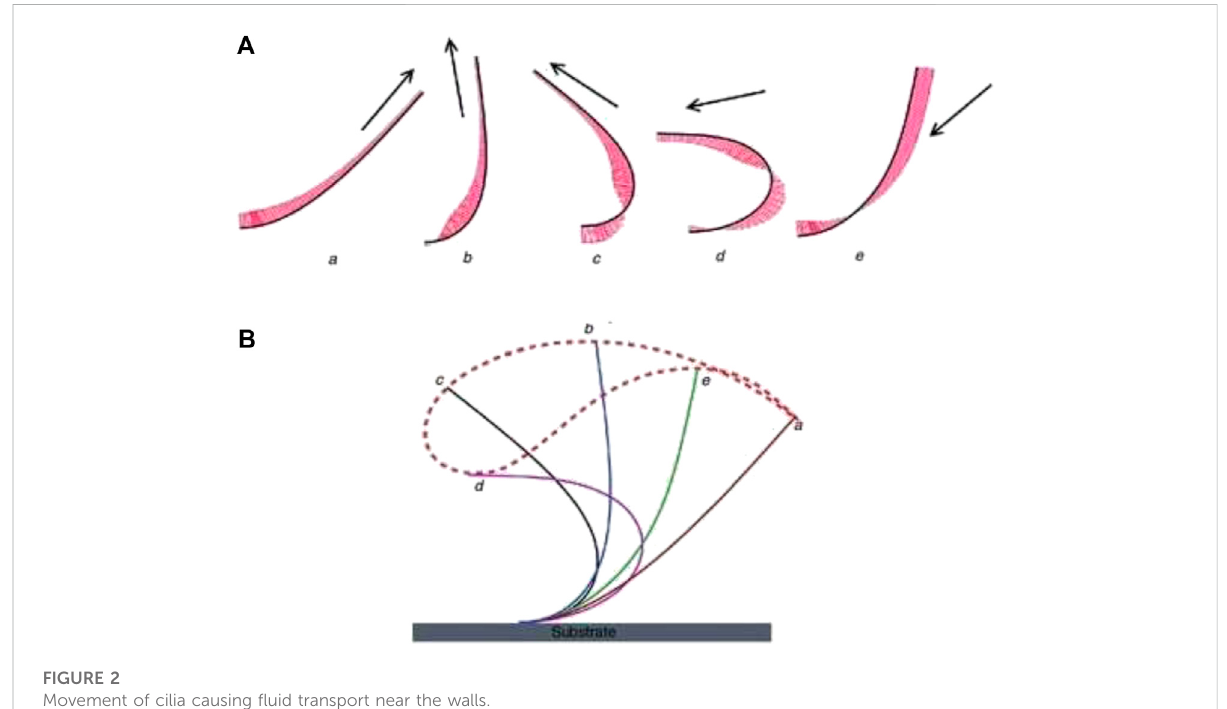
FIGURE 2 Movement of cilia causing fl uid transport near the